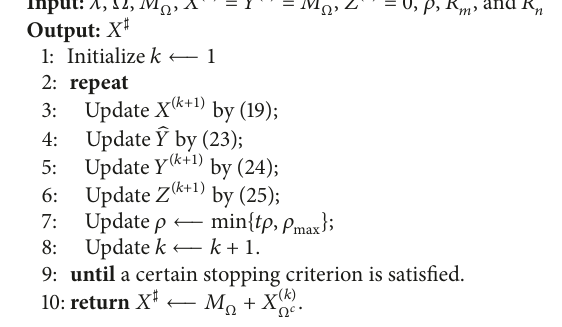
Algorithm 1: Solving problem (14) via